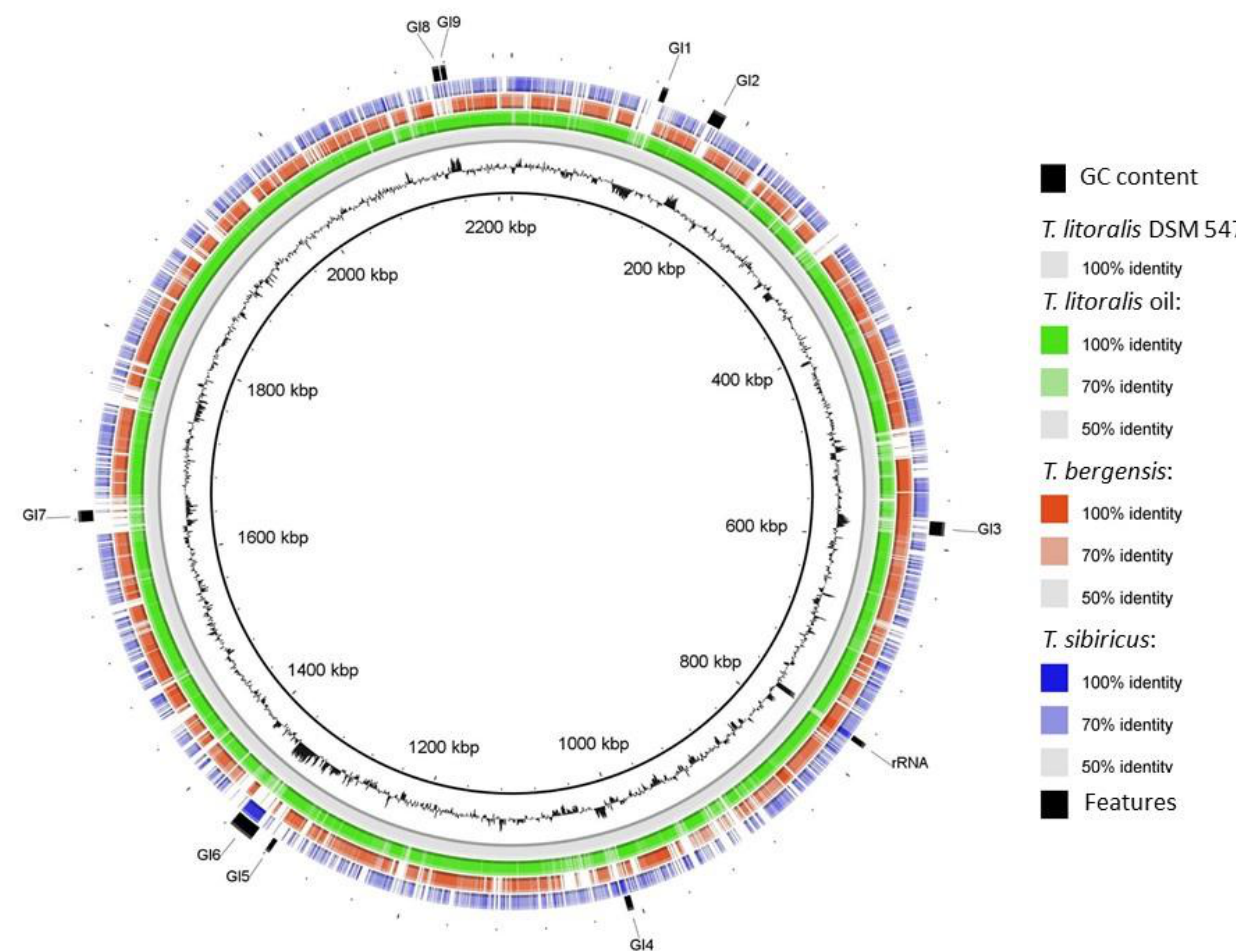
Figure 3. Circular BLAST ring image generator (BRIG) [26] representation of the T. bergensis T7324 T genome as compared with four representative Thermococcus species/strains using T. litoralis DSM5473 as a reference. Genomic islands (GI) were determined by SIGI-HMM implemented in IslandViewer 4 (https://www.pathogenomics.sfu.ca/islandviewer/, accessed on 2 March 2021). Ring colour codes are indicated to the right. The black (innermost) ring indicates the distribution of GC content of T. litoralis DSM5473. Genome sequence accession numbers are the same as in Figure 2. Table 2. Enzymes previously purified from DSM 8774 cultures. Locus Tag Enzyme Reference (in T. bergensis )